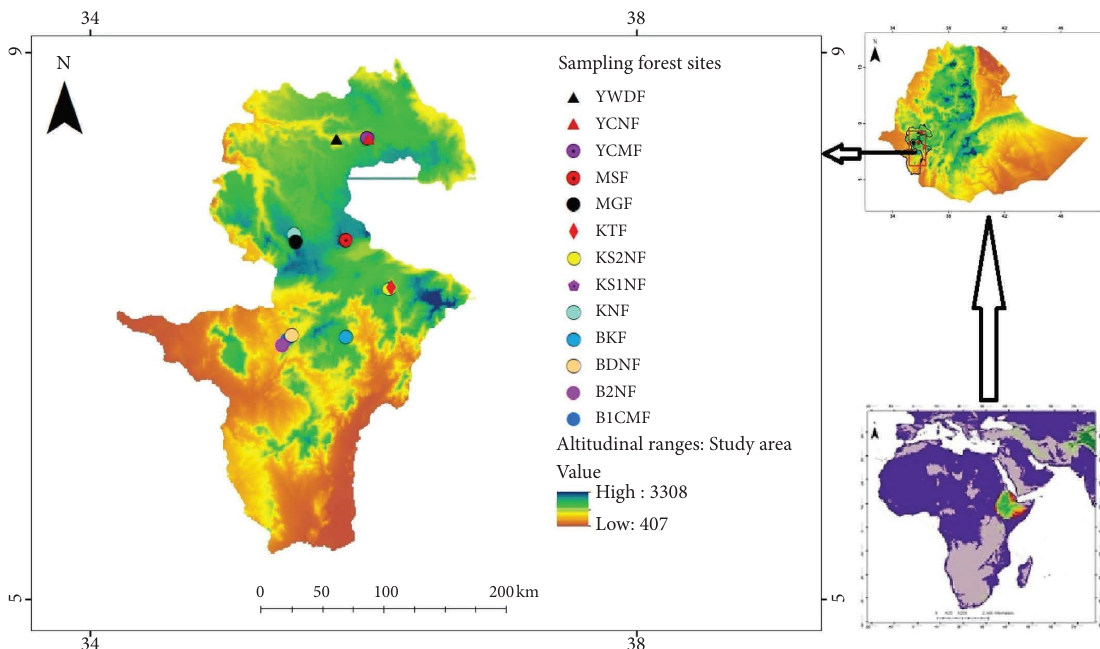
Figure 1: Map the study area including Ilu Aba Bora, Sheka, and Bench-Sheko, and Kafa zones. YCMF � Yayu cofee mixed forest, B1CMF � Bebeka 1-cofee mixed forest, B2NF � Bebeka 2-natural forest, KS1NF � Kafa-Shera1 natural forest, KNF � Kahoshemeta natural forest, BDNF � Bebeka-Duduka natural forest, YCNF � Yayu-Chach natural forest, BKF � Bebeka-Kebereta forest, KS2NF � Kafa-Shera 2 natural forest, MGF � Masha-Gorashewi forest, MSF � Masha-Sherach forest, YWDF � Yayu-Wabu Dureni forest, and KTF � Kafa- Tejadela